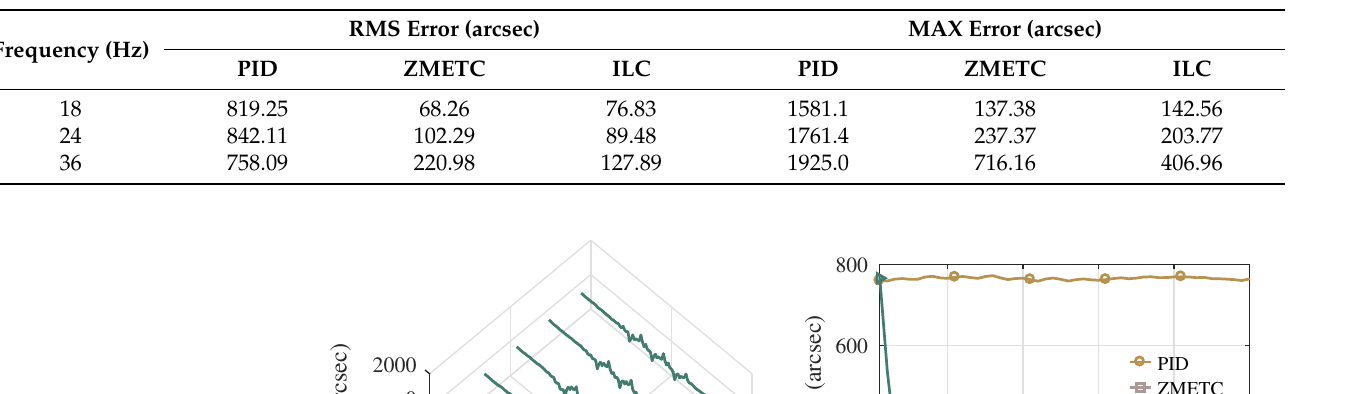
Table 2. Error results of fourth-order motion reference tracking.